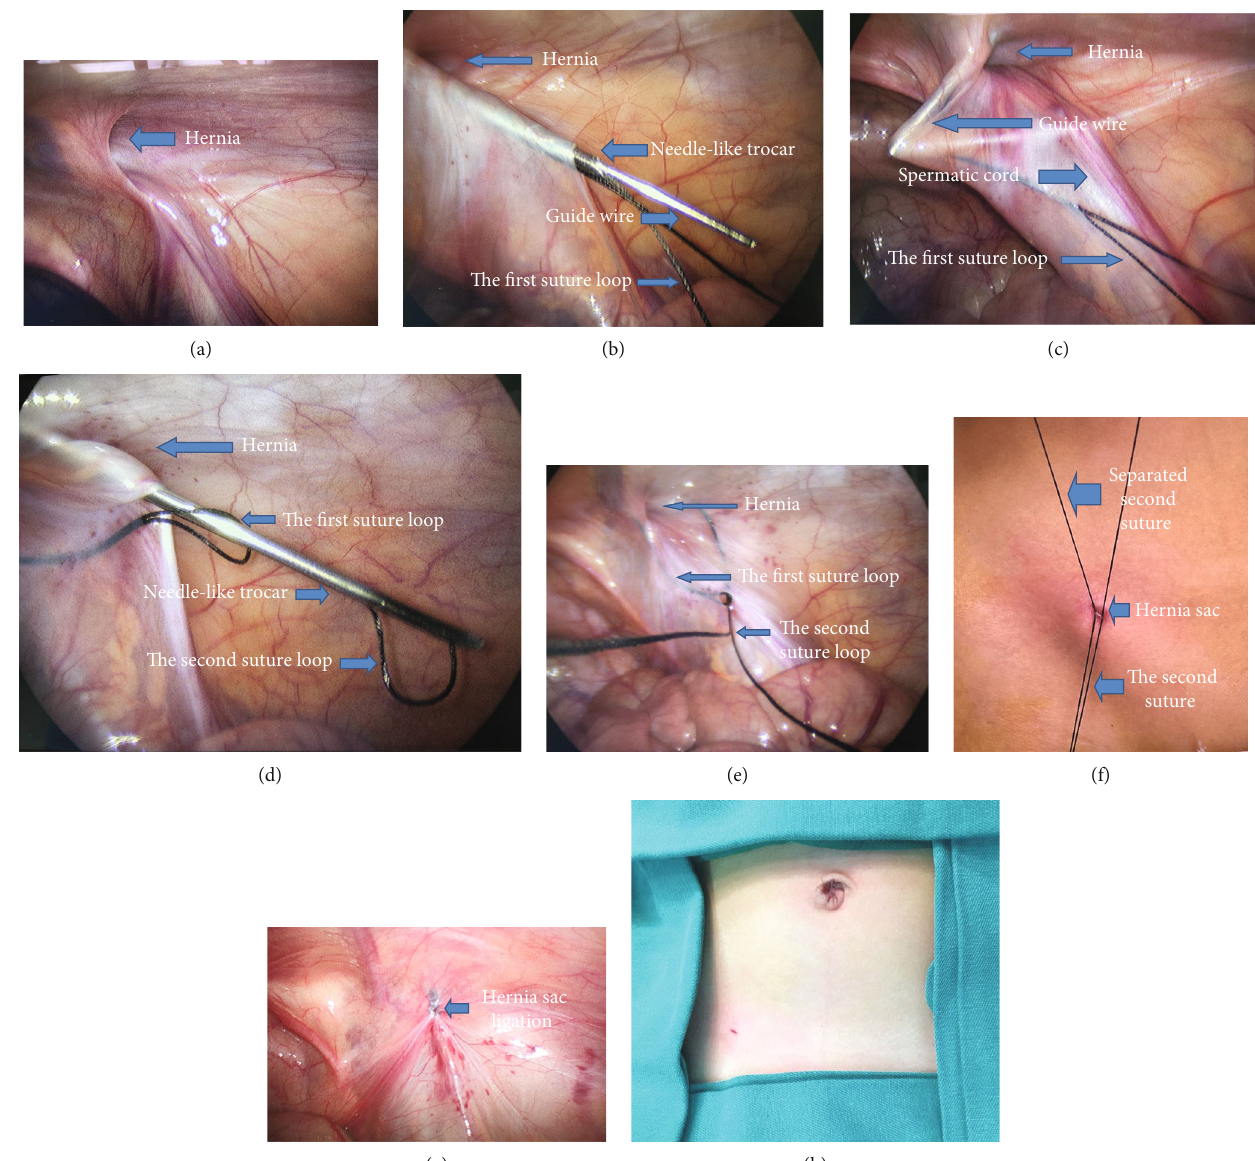
Figure 2: (a – h) Modi fi cation of the technique with single-port laparoscopic assisted hernia sac ligation extraperitoneally. (a) Con fi rming the diagnosis by laparoscopic exploration. (b) The guide wire is inserted into the trocar and stayed it in the cannular while placing the fi rst suture loop in the abdominal cavity and withdrawing the needle-like trocar to insert the second suture loop. (c) The integrity of the hernia sac was reassessed. (d) The second suture loop is pulled into the peritoneal cavity and entered the fi rst suture loop. (e) The second suture loop is locked inside the loop for retrieving the suture. (f) Sutures are tied separately. (g) The ligated suture knots are located in the extraperitoneal space. (h) Suturing incision located in the